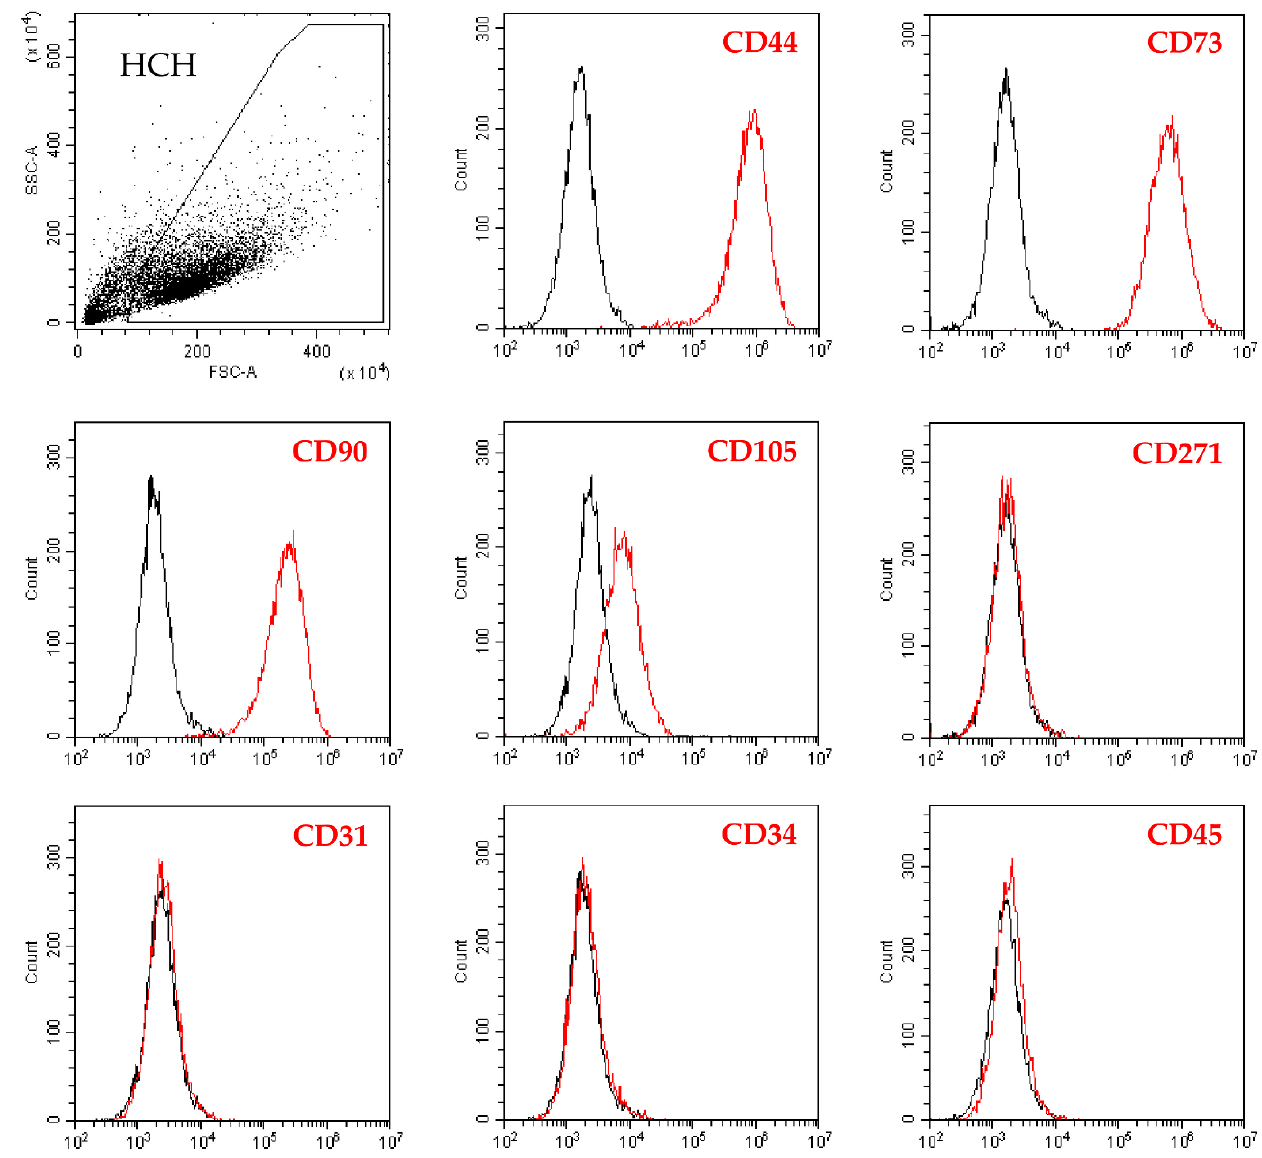
Figure 1. Flow cytometry analysis of human chondrocytes (HCH). After the identification of single cells by exclusion of debris (upper-left panel), staining for chondrocyte (CD44, CD73, CD90 and CD105) markers confirmed cell identity. Bone marrow stromal cell-specific (CD271) marker resulted negative, confirming absence of subchondral bone marrow contamination. Absence of hemato-endothelial (CD31, CD34, and CD45) markers staining further supported HCH identity. Representative plots are shown, unstained in black and stained in red.